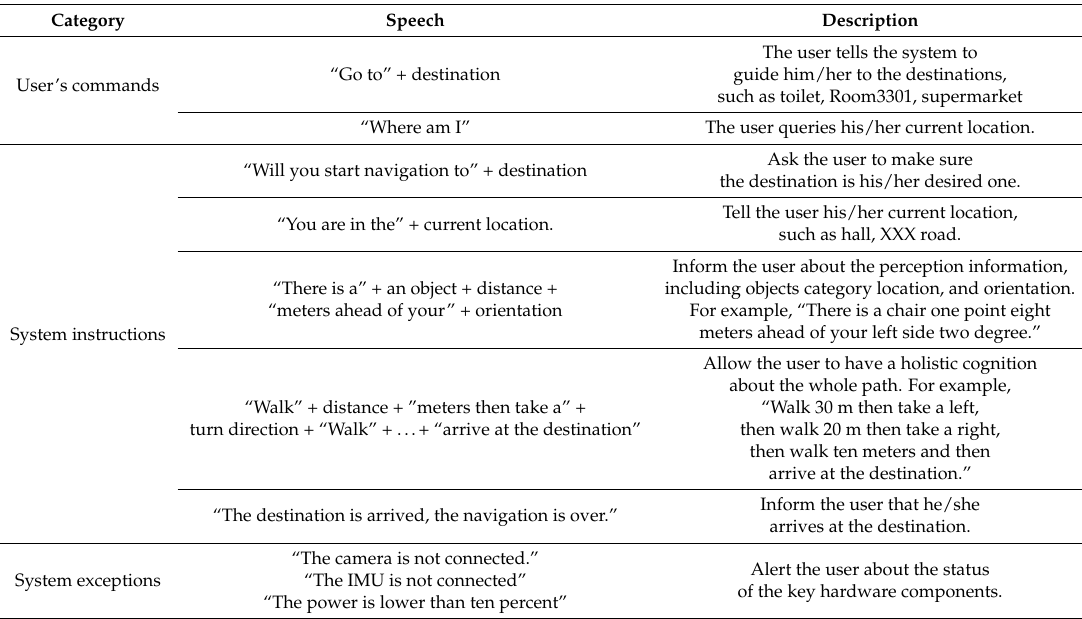
Table 2. Speech of the